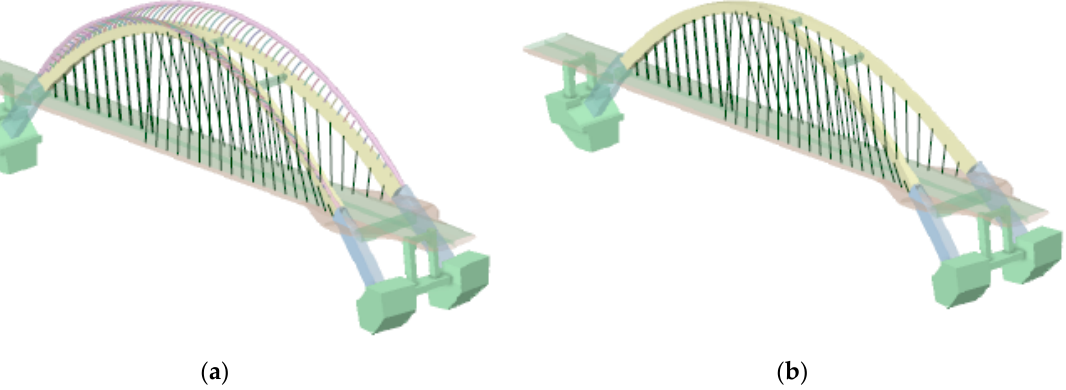
Figure 6. Comparison of three-dimensional effect with or without secondary arch ribs: ( a ) with secondary arch ribs; ( b ) without secondary arch ribs.